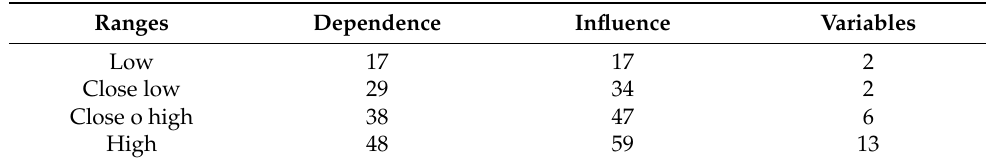
Table 2. Contiguous classes limits considered and the total of